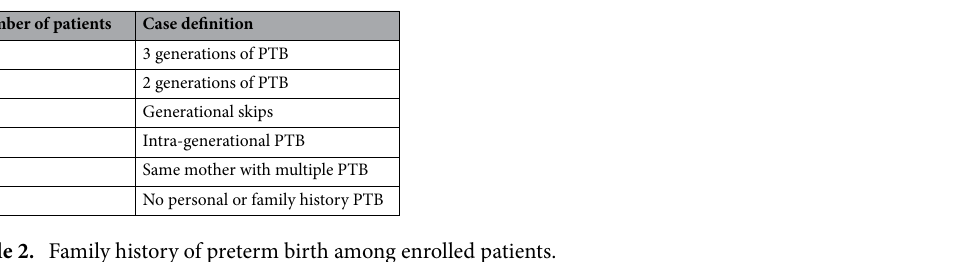
Table 2. Family history of preterm birth among enrolled